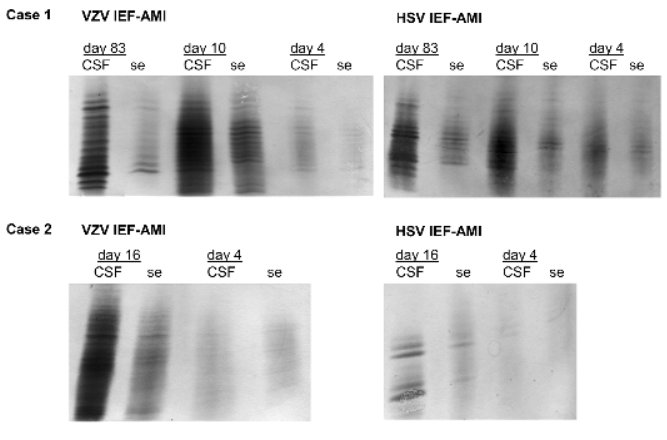
Figure 1 Patient 1 and 2. Results of isoelectric focusing of cerebrospinal fluid (CSF) / serum (se)-pairs, adjusted to the same total IgG level with subsequent